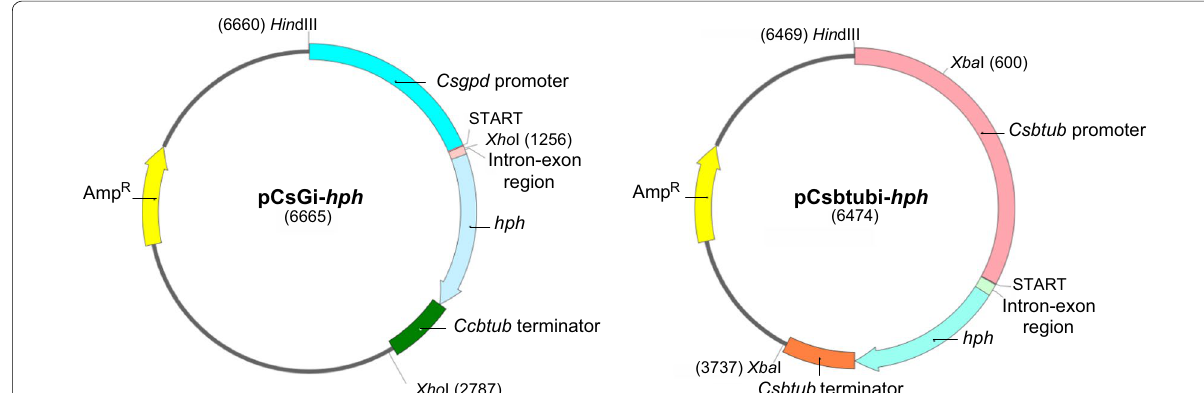
Fig. 1 Schematic of pCsGi- hph and pCsbtubi- hph plasmids. Plasmids pCsGi- hph and pCsbtubi- hph were constructed by combining the homologous promoter region of gpd and beta-tubulin genes from C. subvermispora , respectively, with the coding sequence of bacterial hph . In pCsGi- hph , the first exon, ATG CCC , and the first intron from Csgpd were inserted just before the hygromycin phosphotransferase sequence. In pCsbtubi- hph , the first and second introns, as well as the first exon (encoding 11 amino acids), from Csß - tub were inserted just before the hygromycin phosphotransferase sequence. The plasmid backbones of pCsGi- hph and pCsbtubi- hph are pCRII (Thermo Fisher Scientific Inc.) and pUC19 (Takara Bio Inc.),